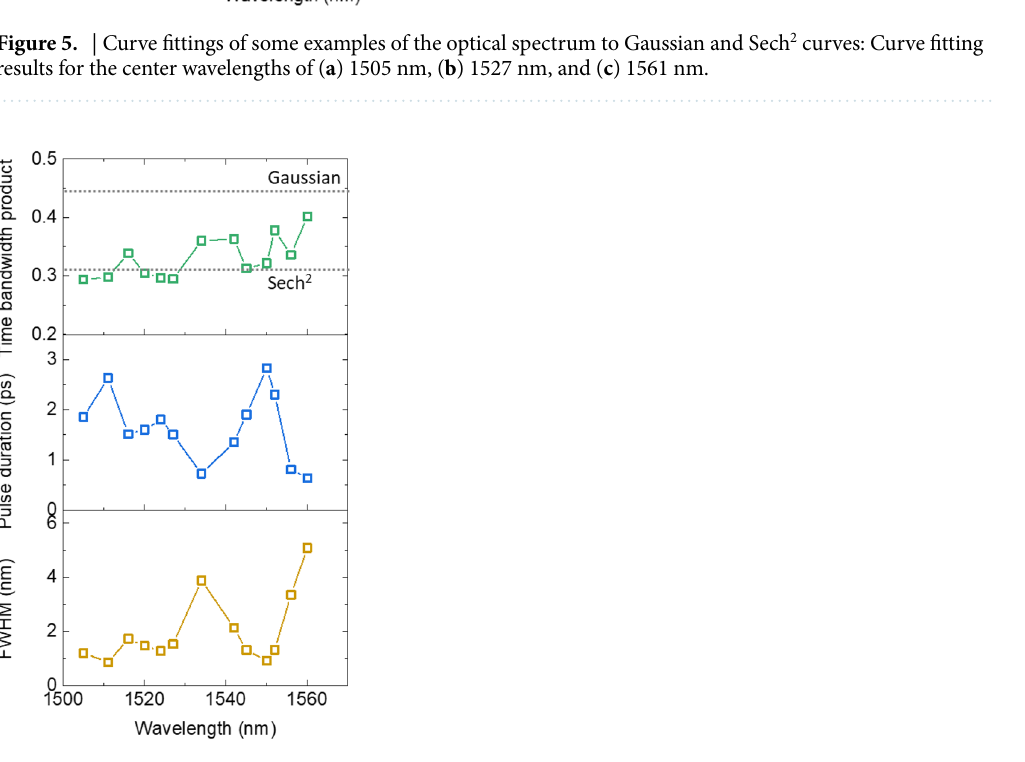
Figure 6. Summary of the optical characteristics of the C-band tunable mode-locked laser. The upper section, middle section and lower section show the time bandwidth product, pulse duration, and optical 3-dB bandwidth,